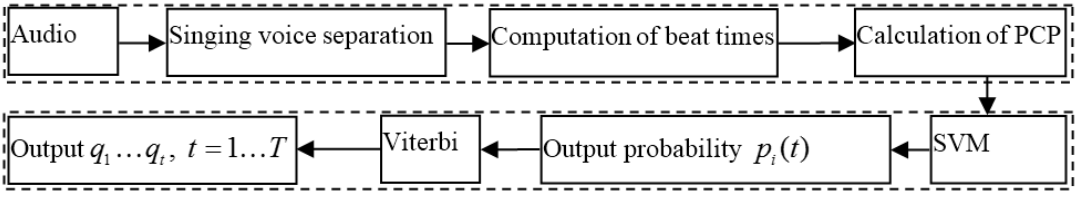
Figure 1. Chord estimation system.